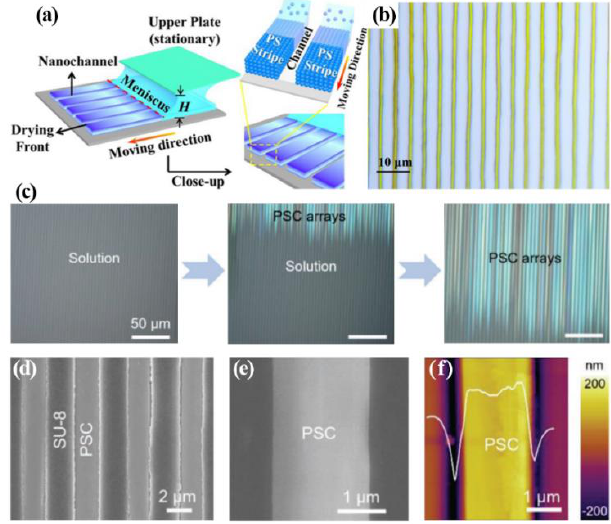
Figure 3. ( a ) Scheme of meniscus − assisted solution-printing to build nanochannels between PS stripes ( b ) Representative image of perovskite single-crystal arrays. Reproduced with permission [46]. Copyright 2020. Wiley-VCH. ( c ) The changing process from the bulk solution to perovskite crystal arrays is due to capillary force after filling the solution into microchannels. ( d ) SEM image of the CH 3 NH 3 PbI 3 arrays. ( e ) Magnified SEM image of ( d ). ( f ) AFM image of one line of perovskite crystal arrays. Reproduced with permission [43]. Copyright 2016. Wiley-VCH.